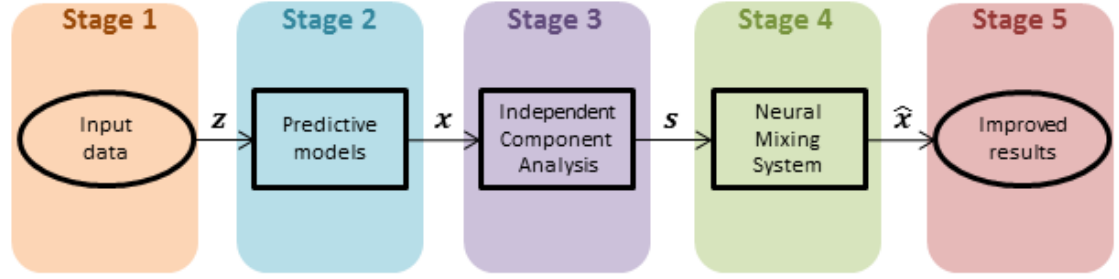
Figure 3. The concept of the filtration stage .